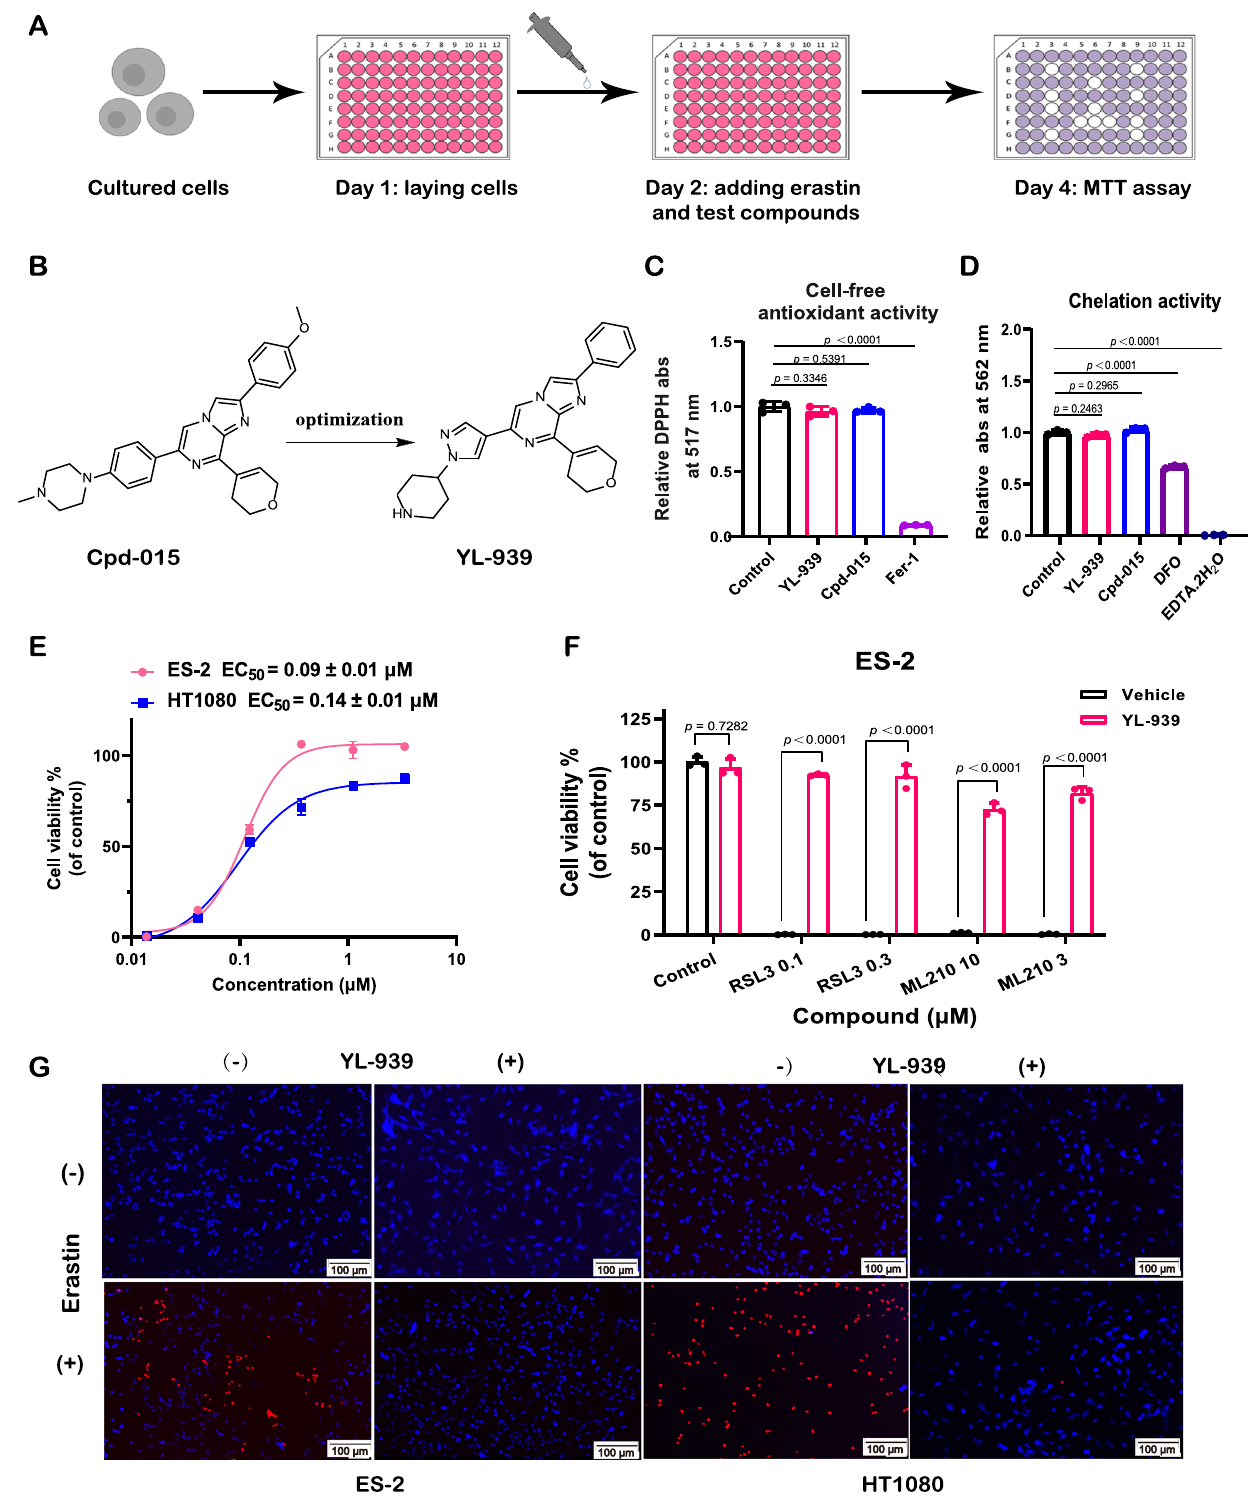
Fig. 1 | Discovery ofthe non-classical ferroptosis inhibitor YL-939. A Screening scheme of ferroptosis inhibitors. Erastin (10 μ M) and test compounds (3 μ M) were addedtotheculturedES-2cells.After48htreatment,MTTassaywasusedtodetect cell viability. B Chemical structure of Cpd-015 and YL-939. C The antioxidant activitiesofCpd-015(50 μ M)andYL-939(50 μ M)analyzedbyDPPH(2,2-Diphenyl-1- Picrylhydrazyl) assay. Data represent the mean±SD of three biological replicates. Statistical analyses were performed by one-way ANOVA with Dunnett ’ s multiple comparisons test. Speci fi c p -values are indicated in the fi gure. D Iron chelating ability of Cpd-015 (50 μ M) and YL-939 (50 μ M). Data represent the mean±SD of three biological replicates. Statistical analyses were performed by one-way ANOVA